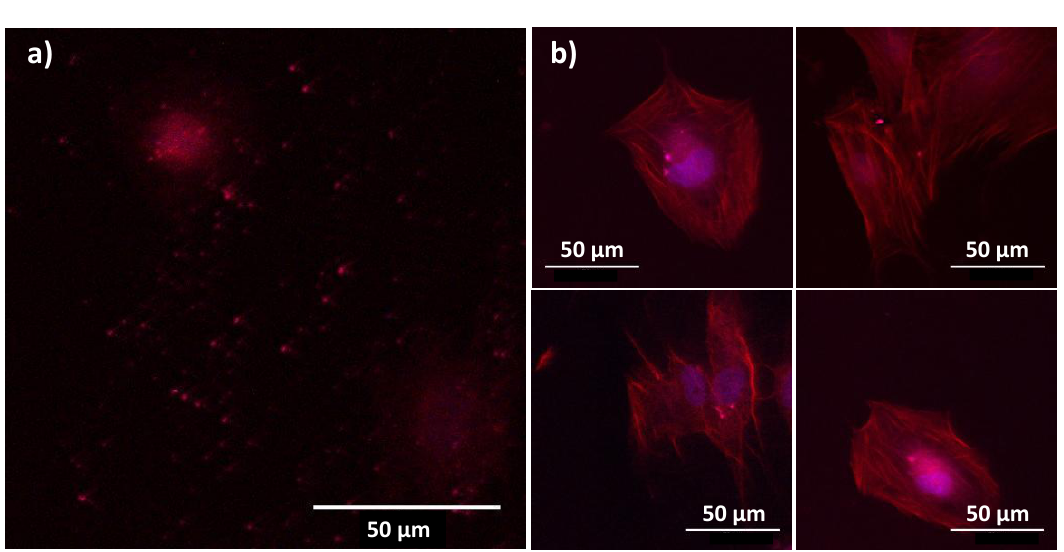
Figure 11. Panel of two photon images collected on BJH cells contacted with citrated β -NaY 0.8 Eu 0.2 F 4 @ γ -Fe 2 O 3 particles (48 h and 50 µ g · mL − 1 ) and counterstained with blue DAPI and red TRITC dyes. An excitation wavelength of 830 nm was used for this purpose and the images were selected to highlight ( a ) non-internalized particles and ( b ) internalized ones. The particles appear as bright red dots.